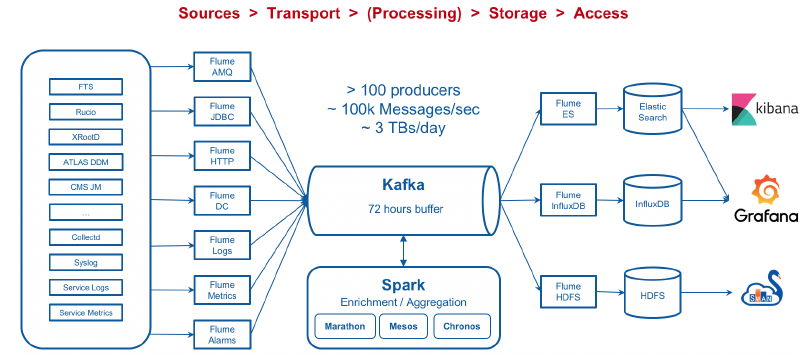
Figure 1. The CERN MonIT Unified Monitoring Architecture